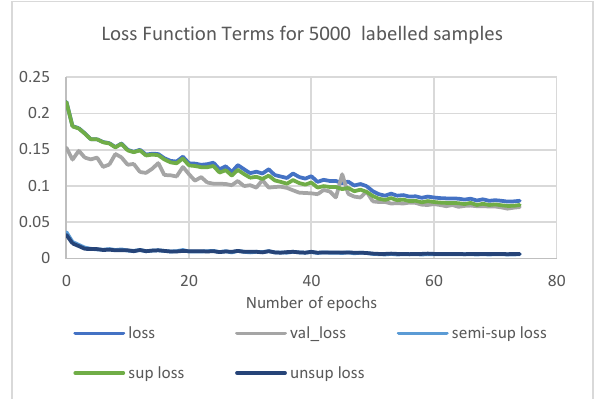
Figure 5 . Loss function terms of the semi-supervised method for 𝑆 5000 . Loss is the aggregate loss, sup loss is the supervised component of the loss function ( 𝐿 1 ), semi-supervised loss is the consistency regularization term for the labelled samples ( 𝑅 1 ), and unsup loss is the consistency regularization term for the unlabelled samples ( 𝑅 2 ) of the